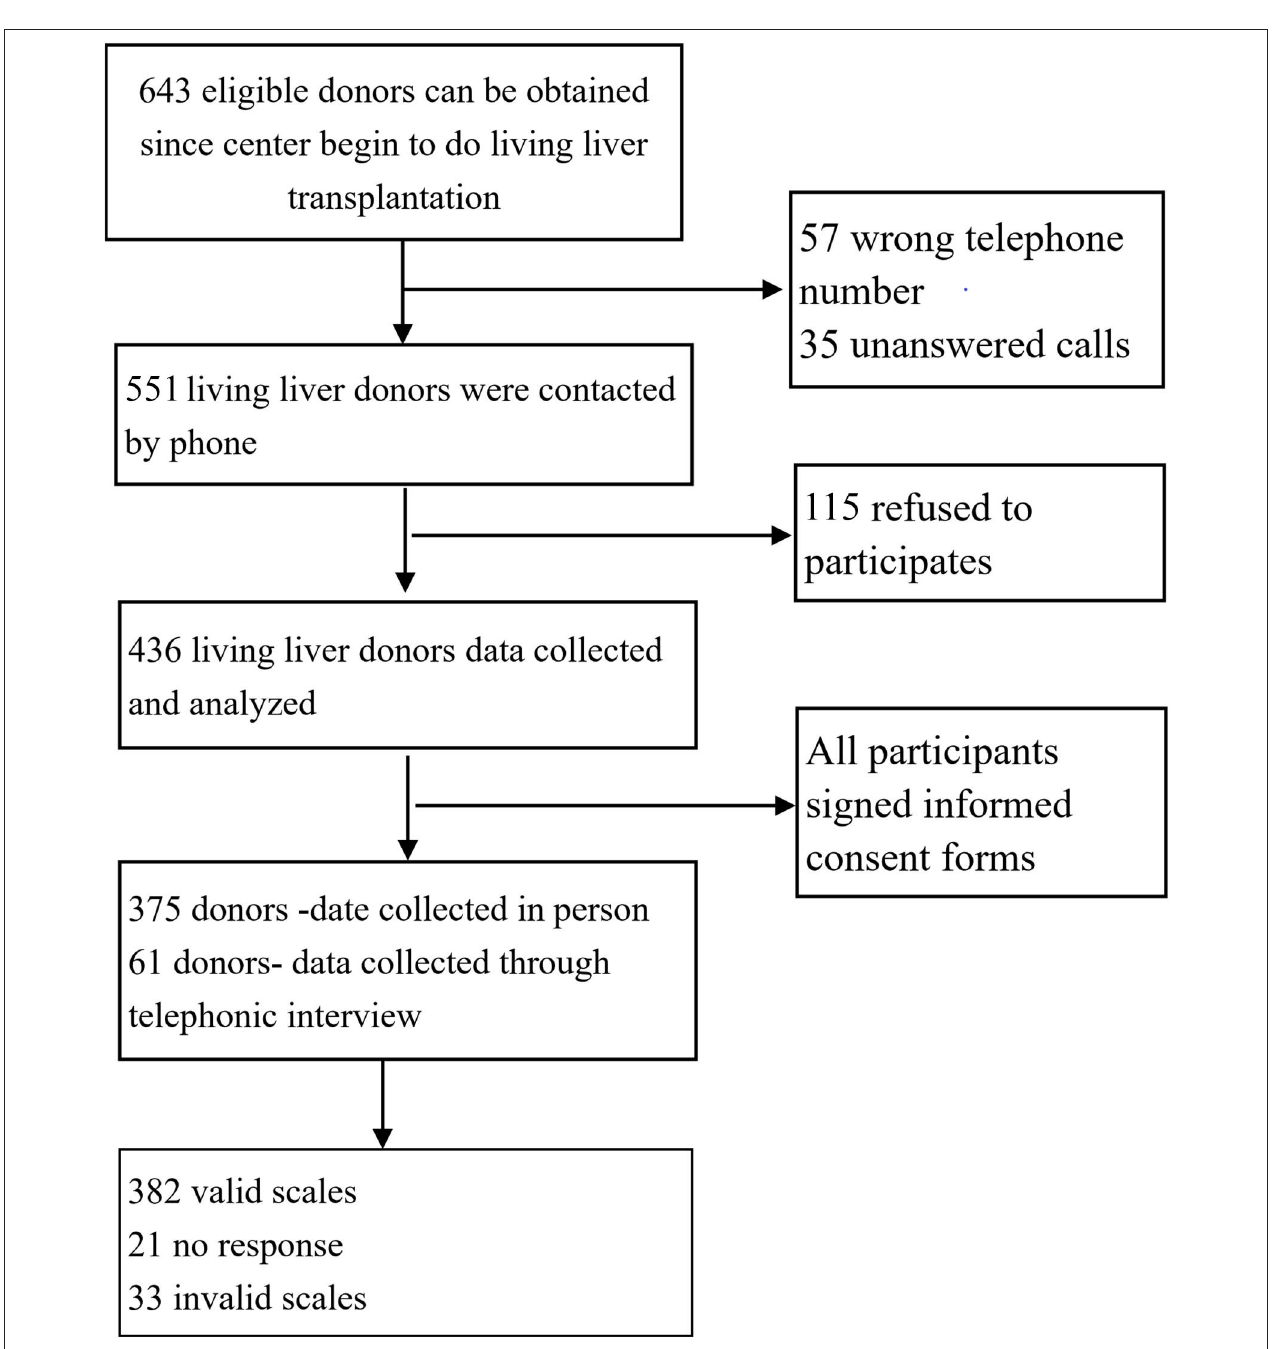
FIGURE 1 | Flow diagram for participants